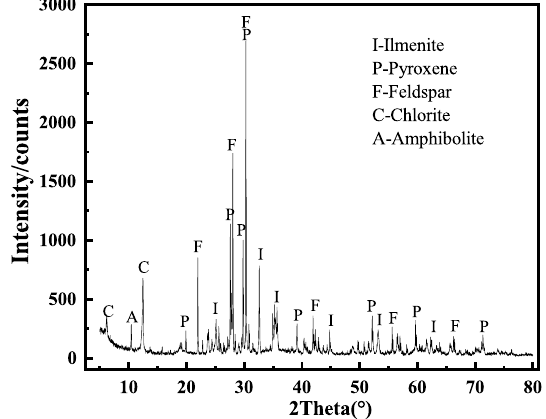
Figure 1. X-ray diffraction pattern of mineral